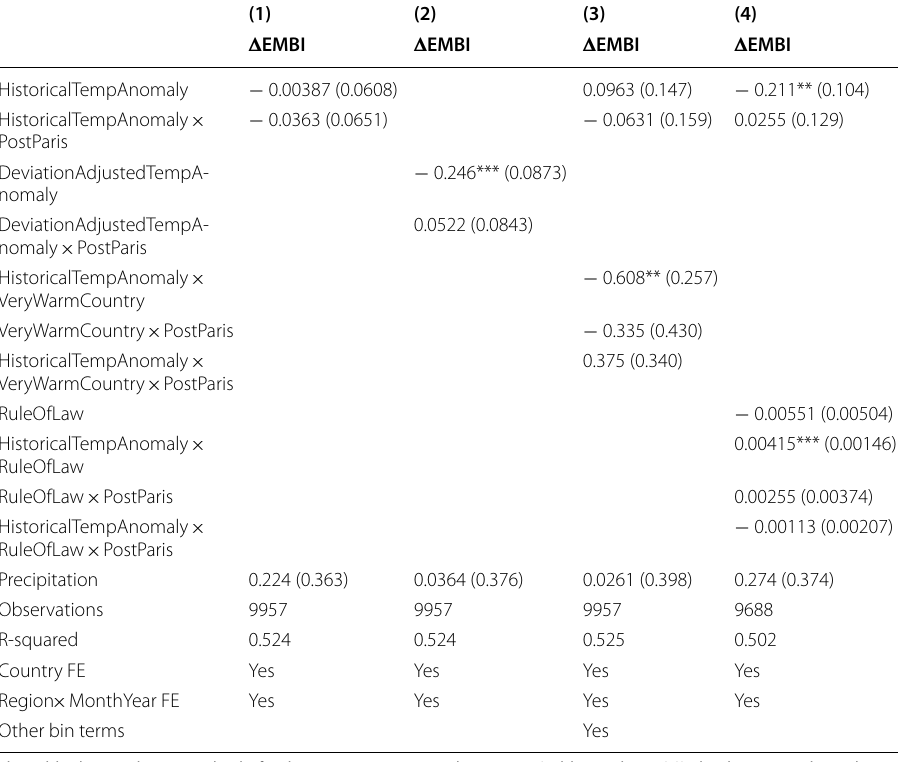
This table shows robustness checks for the temperature anomaly measure (Table 6, column (3)), the deviation-adjusted temperature variable (Table 6, column (6)), the bin-regression analyzing the warmness of countries using 5 ◦ C intervals (Table 7, column (2)) and the interaction with institutional characteristics (rule of law index, Table 9, column (1)). PostParis is a dummy with value 1 after the Paris Climate Agreement in December 2015. Estimation in column (3) also includes all other bin categories (cold as base category) and respective interactions. Standard errors (in parentheses) are clustered at the country level and control for heteroscedasticity and serial correlation, ***, ** and * indicate statistical significance at the 1%, 5% and 10% level, respectively. See Table 18 for variable definitions and